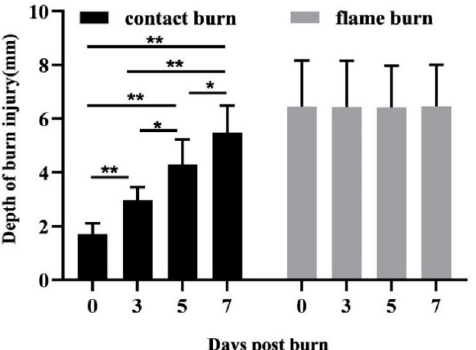
Figure 2. Depth of tissue damage after contact and flame burns. Composite tissue samples from 6 different donors were subjected to contact (contact burned) or flame burns (flame burned). Samples were preserved immediately after injury (day 0) or further maintained in vitro for three (day 3), five (day 5), or seven days (day 7). Later, tissue sections were analyzed using HE staining and viewed directly under a microscope. The chart shows the mean depth (0–10 mm) of the burn-damaged zones. Damaged tissue was identified by the destruction of the adipocyte network based on microscopic evaluation of the HE-stained samples. The burn damage depth was defined as the distance from the most distally detected tissue damage to the most superficial core of the burned epidermis. Statistical significance is shown with * p ≤ 0.05 or ** p ≤ 0.01.